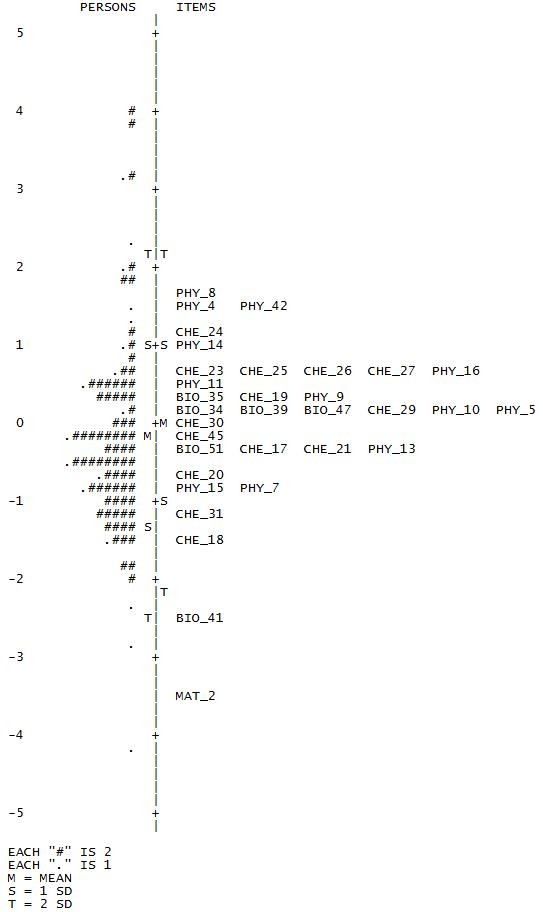
Item-Person-Map, HAM-Nat-uni, Sample A.